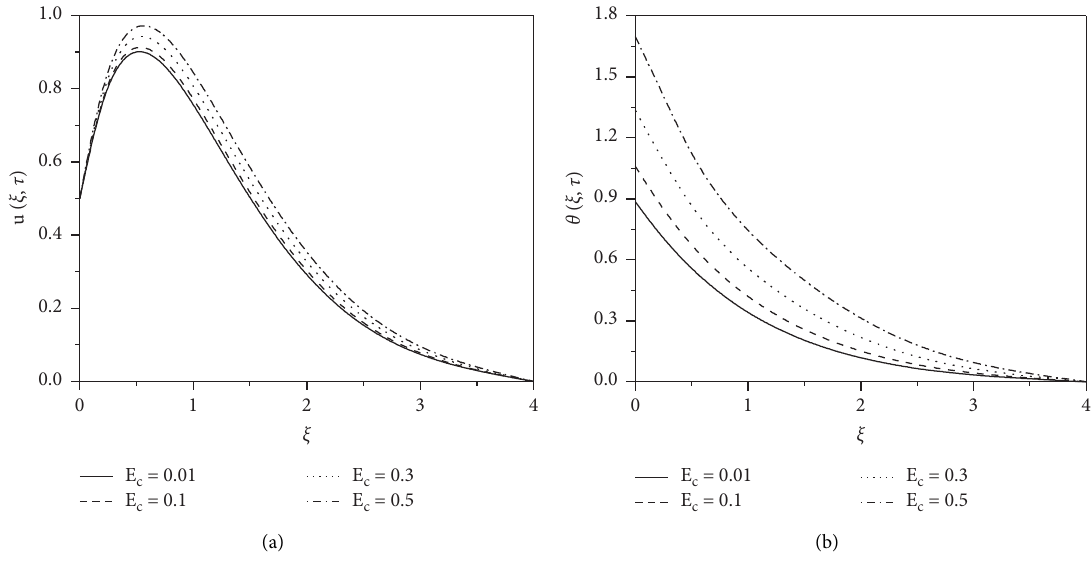
Figure 5: Variation of (a) velocity u ( ξ , τ ) and (b) temperature θ ( ξ , τ ) against ξ for various values of E